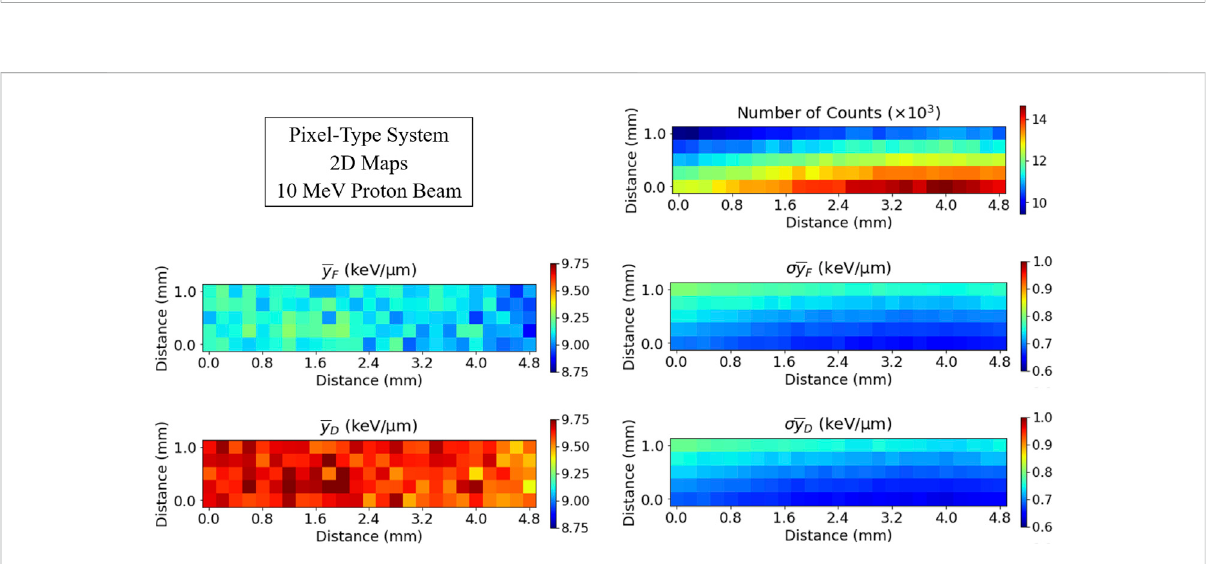
FIGURE 8 2Dmicrodosimetrymapsobtainedwiththepixelsystemfor10 MeVprotons.Top:numberofparticlesdetected.Middle:frequency-meanlineal energy and its standard deviation. Bottom: dose-mean lineal energy and its corresponding standard